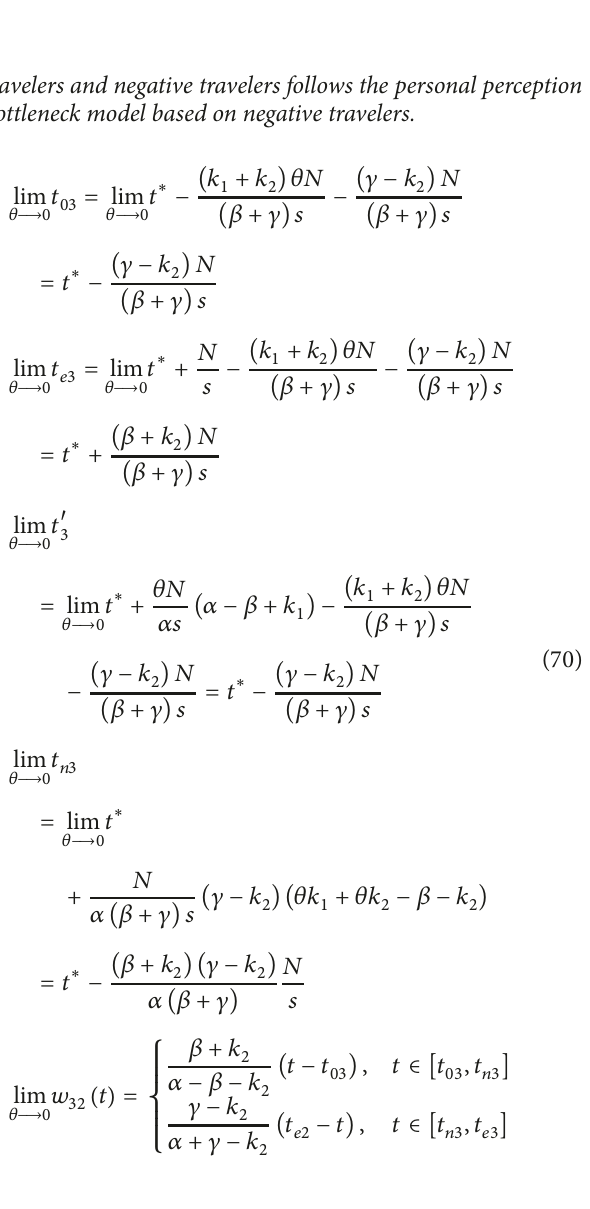
Figure 3:Cumulativedepartures and arrivals atequilibrium in Case 3.